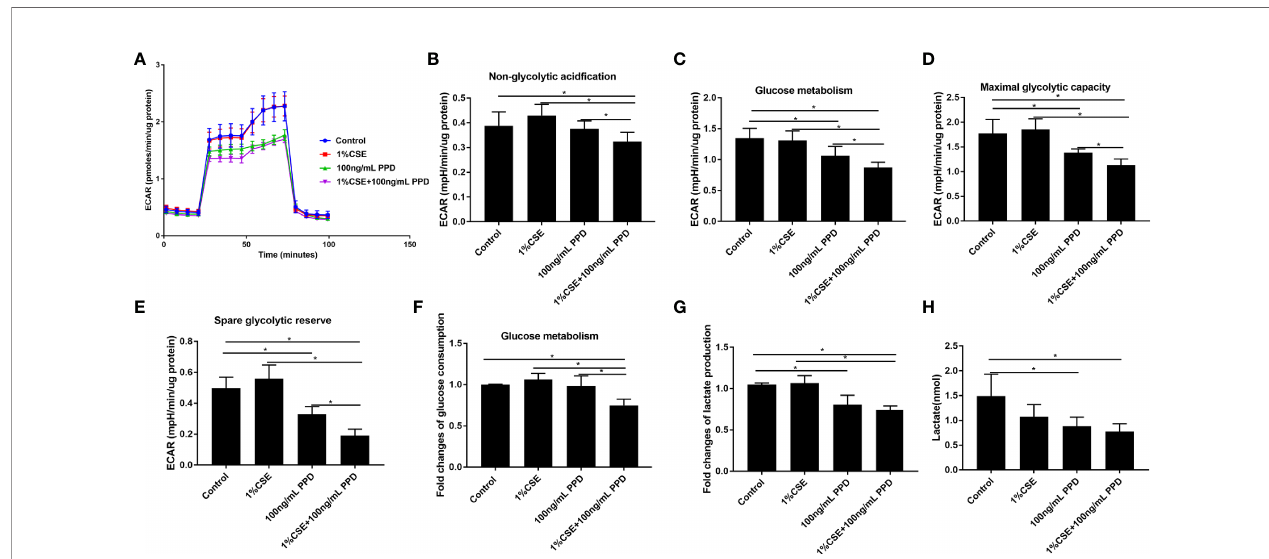
FIGURE 4 | Decreased glycolytic fl ux in NK-92 cells upon CSE and PPD exposure. NK-92 cells were stimulated with 1% CSE and/or 100 ng/ml PPD accordingly for another 24 h The speci fi c grouping is as follows: control (control group), 1% CSE (CSE group), 100 ng/mL PPD (PPD group), 1% CSE+100 ng/mL PPD (CSE- and PPD-coexposed group). NK-92 cells were then plated onto Seahorse Bioscience plates. (A) Representative glycolytic stress tests were performed with sequential addition of glucose (10 mM), oligomycin (2 m M), and 2-deoxy- D -glucose (50 mM). (B – E) Indices of glycolytic pathway (nonglycolytic acidi fi cation, glucose metabolism, maximal glycolytic capacity, and spare glycolytic reserve) of CSE- and PPD-coexposed NK-92 cells. (F, G) Glucose consumption and lactate production were detected. (H) Changes in major metabolic changes related to cellular energetic pathways (glycolysis) were detected by LC-MS/MS. n ≥ 3 independent experiments. One-way analysis of variance (ANOVA) with Bonferroni or Dunnett ’ s T3 posttest analysis was performed for comparisons between multiple groups. * p <